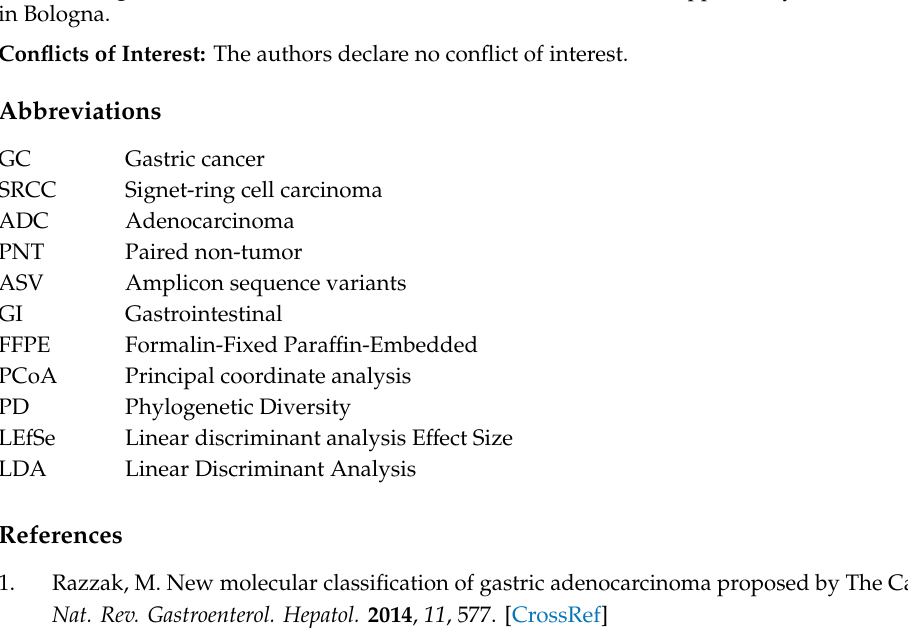
Table S1: LefSe analysis at the ASV level, Table S2: Details of pathways reported in the circos-plot, Table S3: Relative abundance in microbial communities in SRCC, SRCC PNT, ADC and ADC PNT